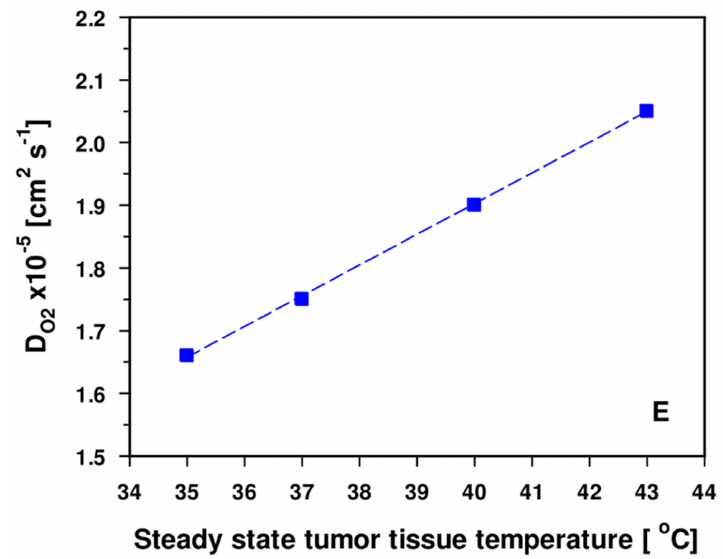
Figure 1. Changes of relevant physiological parameters upon localized mHT as a function of tumor temperature. Results show tumor blood flow (TBF) and oxygen (O 2 ) supply (=TBF × arterial O 2 concentration, panel ( A )), microvascular oxyhemoglobin (HbO 2 ) saturation, and tumor tissue O 2 partial pressure ( pO 2 , panel ( B )) , in situ O 2 consumption ( V O 2 ) and—completely independent of blood flow—the O 2 consumption rate of isolated tumor cells in vitro ( MRO 2 ), panel ( C )). There is clear evidence that TBF and the directly flow-dependent parameters have a maximum between 39.5 ◦ C and 40.5 ◦ C, whereas—at maintained, unrestricted O 2 supply under in vitro conditions— MRO 2 values have a distinct maximum at 42 ◦ C with a decline at temperatures ≥ 43 ◦ C (at maintained, adequate O 2 supply under in vitro conditions). The oxygen extraction rate (= O 2 uptake/O 2 supply), a measure of the adequacy of the O 2 supply to the tissue, increases with rising temperature (panel ( D )). Oxygen diffusivity ( D O 2 ) increases linearly with temperature (panel ( E )). Based on data provided in [32–35]. Values are averaged